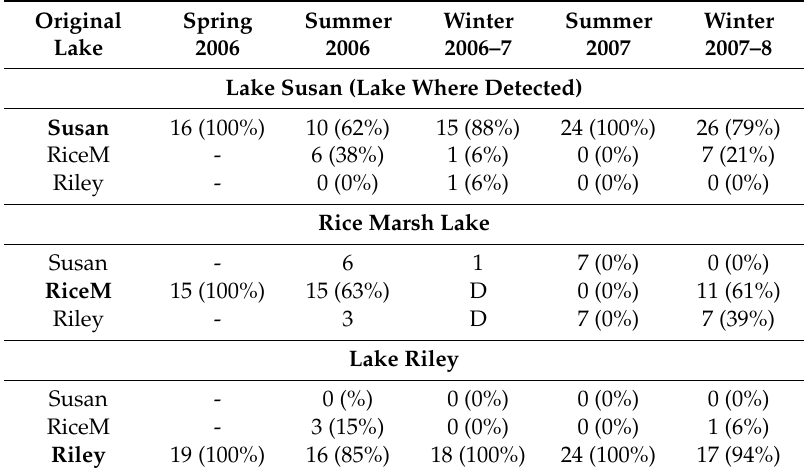
Table 6. The number of adult carp radio-tagged in lakes Susan, Rice Marsh, and Riley and their locations in these lakes by season (% = portion of the population they represent; some of these data have been published [37]). Lakes were carp were captured is